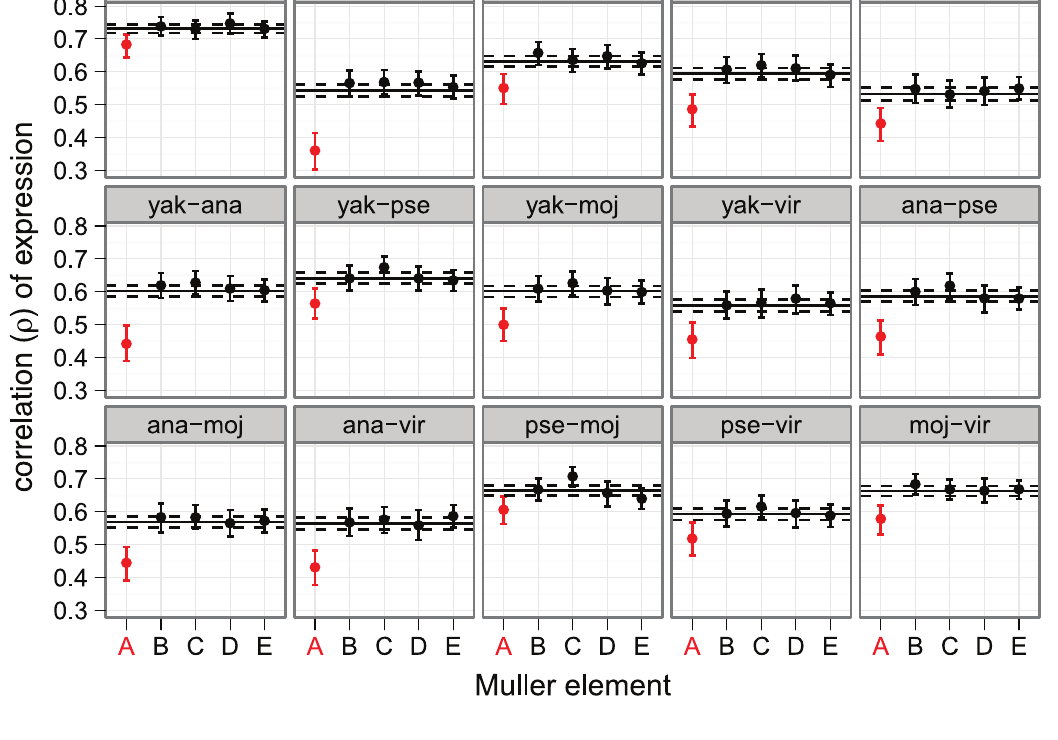
Faster-X Expression Evolution